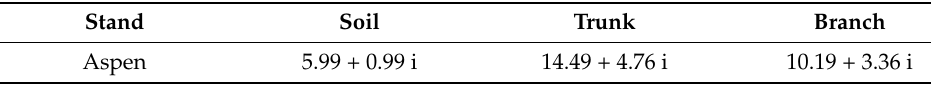
Table 3. The permittivity of soil and canopy layers.